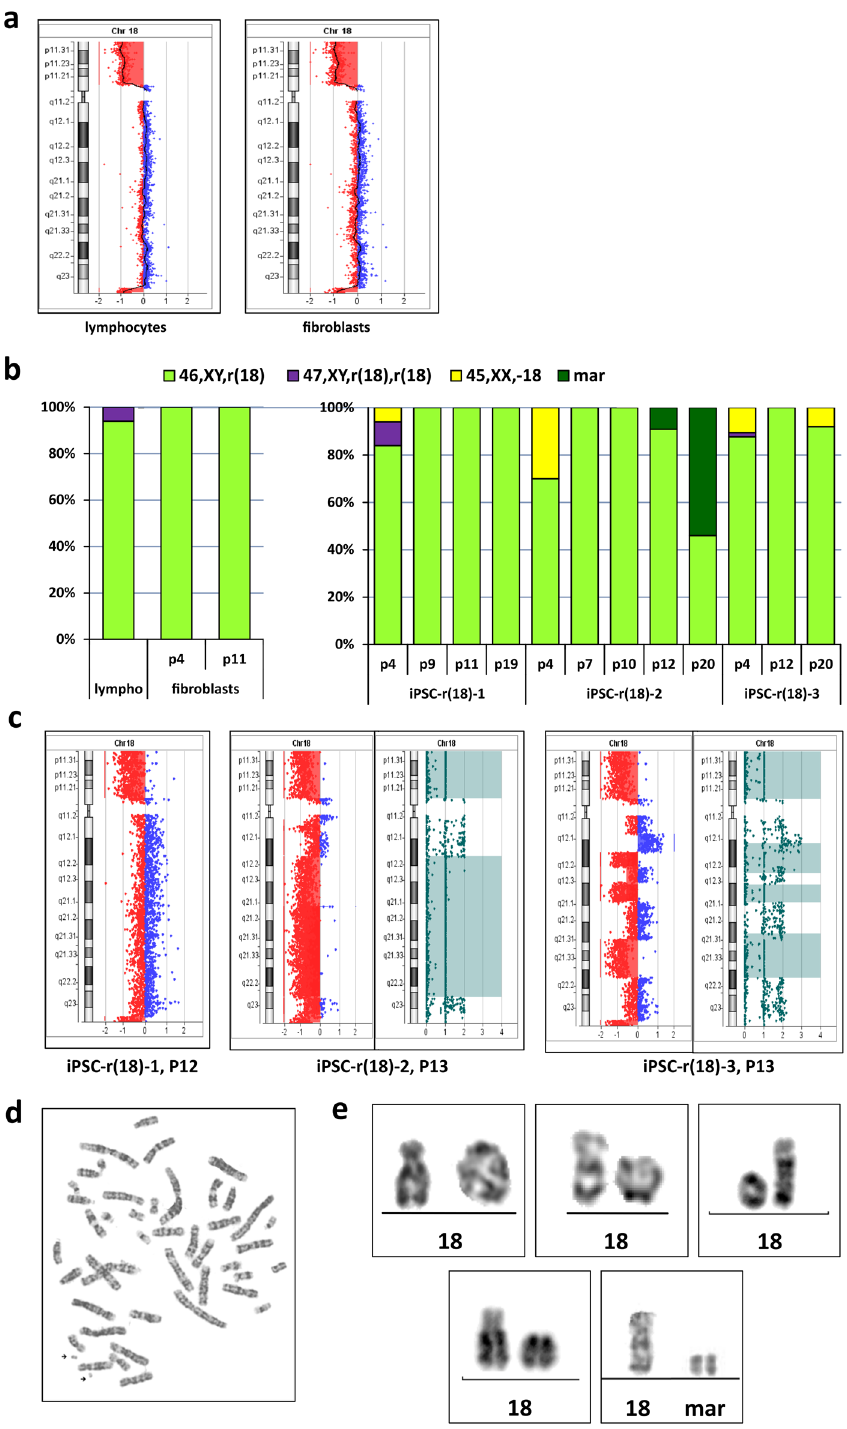
Figure 3. Results of GTG and molecular karyotyping of cell lines with r(18). ( a ) aCGH profiles of chromosome 18 showing a terminal deletion 1.238 Mb at 18q23 and a large (13.52 Mb) deletion at 18p11.32p11 in lymphocytes (left) and fibroblasts (right) [CytoGenomics (v. 3.0.6.6) (https ://www.agile nt.com/en/downl oad-agile nt-cytog enomi cs-softw are)]. ( b ) Karyotype rates in lymphocytes and fibroblasts (left) and iPSC lines (right) at different passages. ( c ) aCGH profiles of chromosome 18 in 3 iPSC lines: iPSC-r(18)-1 with a stable ring structure, iPSC-r(18)-2 with signs of multiple rearrangements or chromothripsis with the absence of most genetic content, and iPSC-r(18)-3 with signs of multiple rearrangements or chromothripsis [CytoGenomics (v. 5.0.2.5) (https ://www.agile nt.com/en/downl oad-agile nt-cytog enomi cs-softw are)]. ( d ) Example of metaphase spread with two marker chromosomes in line iPSC-r(18)-2. ( e ) Images of chromosome 18 pairs in fibroblasts and iPSCs with r(18) and its